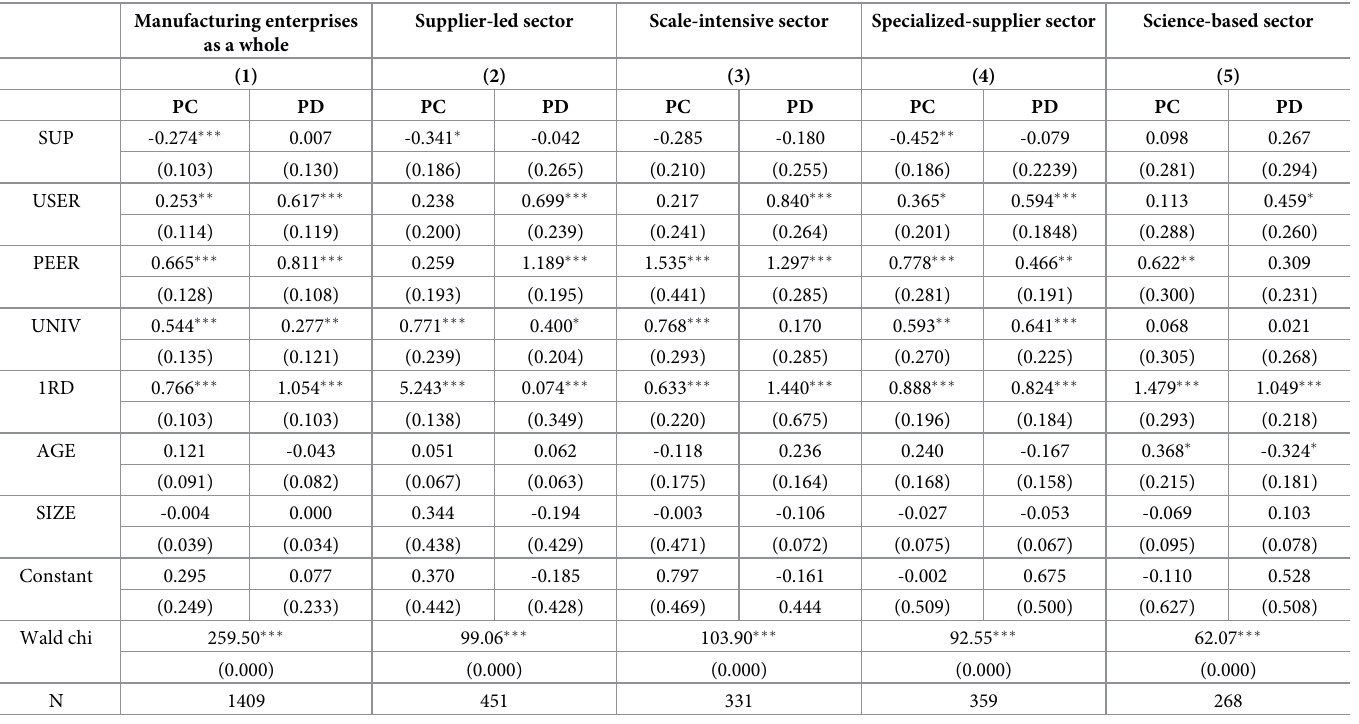
Table 4. Bivariate Probit model regression